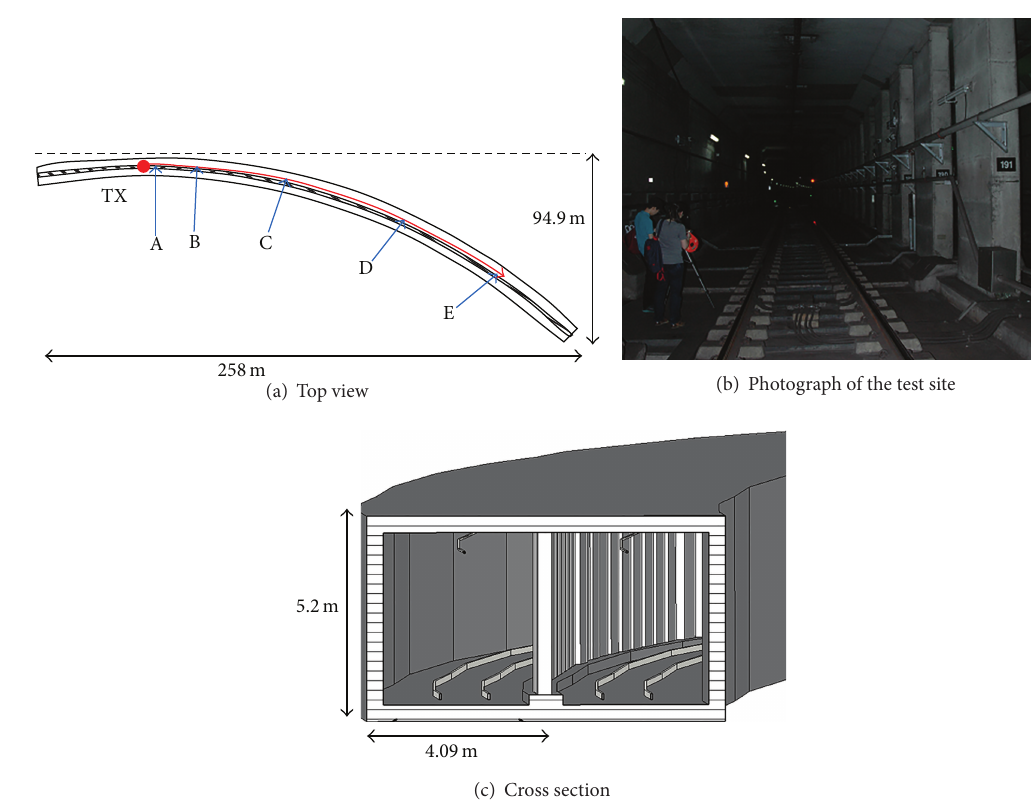
Figure 3: Dimension of a tunnel used to measure propagation loss.